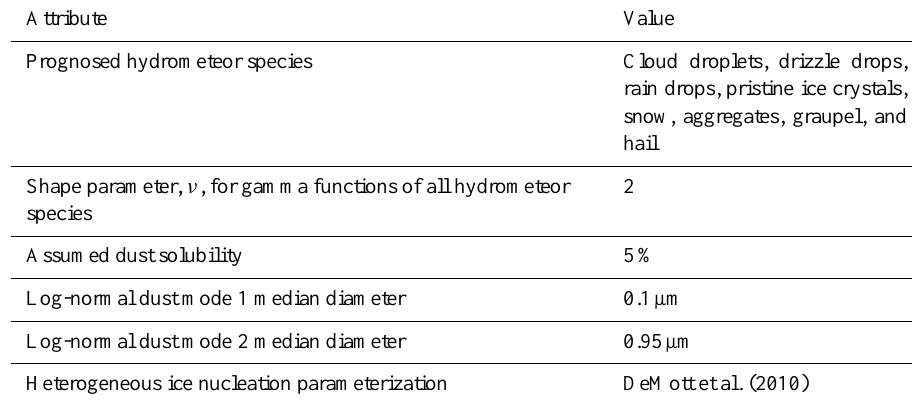
rain drops, pristine ice crystals, snow, aggregates, graupel, and hail